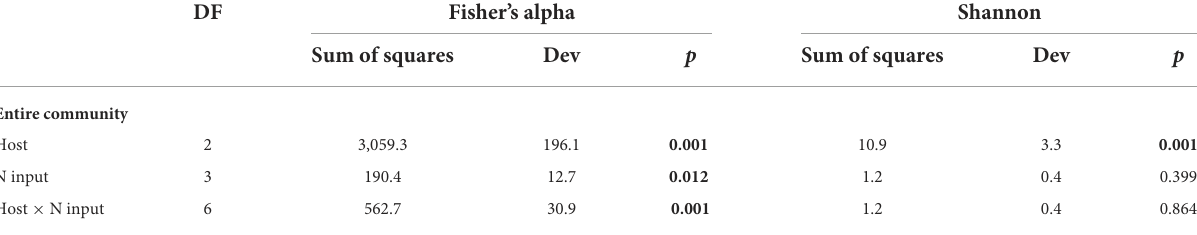
TABLE 1 Diversity statistics for the fungal endophytes in three hosts based on a multispecies generalized linear model. DF Fisher’s alpha Shannon Sum of squares Dev p Sum of squares Dev